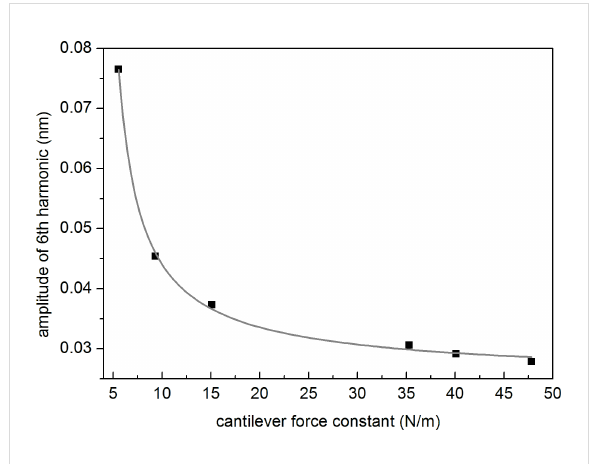
Figure 2: Simulated dependence of the amplitude of the 6th harmonic as a function of: (a) tip radius, (b) sample’s Young’s modulus and (c) free oscillation amplitude, respectively. The calculated points (filled black circles) have been performed for k c = 26 N/m, f 0 = 300 kHz and Q = 400 with A sp = 0.5 A 1 and A 1 = 20 nm for (a) and (b) and have been fitted to the gun-shaped function G described in Equation 4. The values of the g 1 , g 2 and g 3 parameters obtained from the fits are: (a) g 1 = − 1.63, g 2 = 22.727 nm − 1 , g 3 = 5.007 nm − 1/2 , (b) g 1 = 4.373 GPa·nm − 1 , g 2 = 22.84 nm − 1 , g 3 = 10.737 GPa 1/2 ·nm − 1 and (c) g